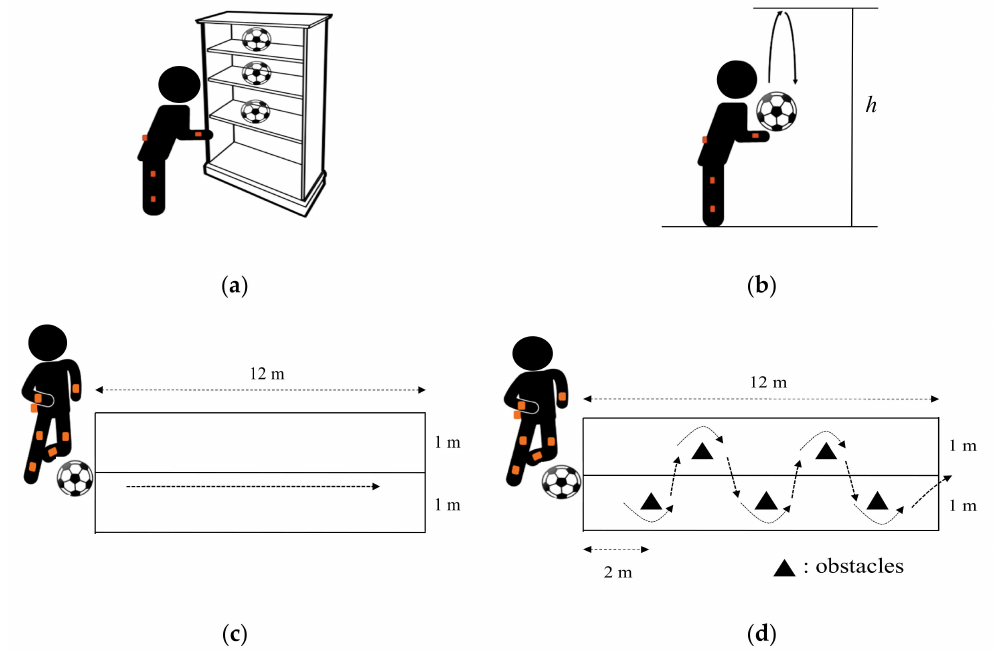
Figure 3. Illustrations of the tests: ( a ) picking up the ball at the spot it was placed, which was at three di ff erent heights, ( b ) throwing-and-catching the ball, where “ h ” denoted the height the ball should reach, ( c ) dribbling the ball along a straight line, where the dotted arrow showed the dribbling direction, and ( d ) dribbling the ball along a zigzag line with five obstacles staggered in a zigzag